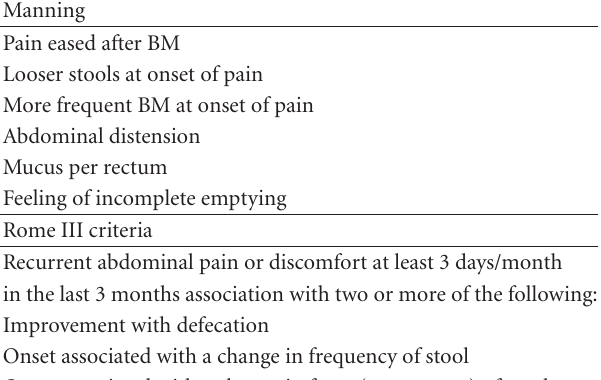
Table 1: Criteria to identify IBS. Manning